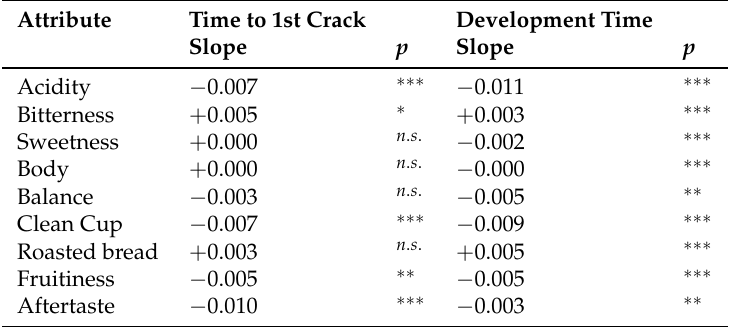
Table 5. Linear regression slopes quantifying the change in sensory attributes as a function of change in timing parameters “time to first crack” and “development” time. The significance level associated with the regression coefficient is also reported ( n . s . p > 0.05; ∗ p < 0.05; ∗∗ p < 0.01; ∗∗∗ p < 0.001). Attribute Time to 1st Crack Development Time Slope p Slope p − 0.007 − 0.011 ∗∗∗ + 0.005 ∗ + 0.003 ∗∗∗ Sweetness + 0.000 n . s . − 0.002 ∗∗∗ Body + 0.000 n . s . − 0.000 ∗∗∗ Balance − 0.003 n . s . − 0.005 ∗∗ Clean Cup − 0.007 ∗∗∗ − 0.009 ∗∗∗ Roasted bread + 0.003 n . s . + 0.005 ∗∗∗ Fruitiness − 0.005 ∗∗ − 0.005 ∗∗∗ Aftertaste − 0.010 −